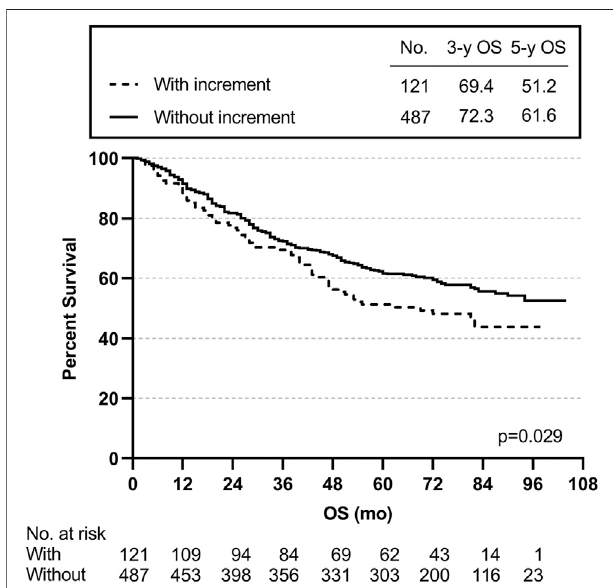
FIGURE 5 | Overall survival curve by post-preoperative CEA increment.